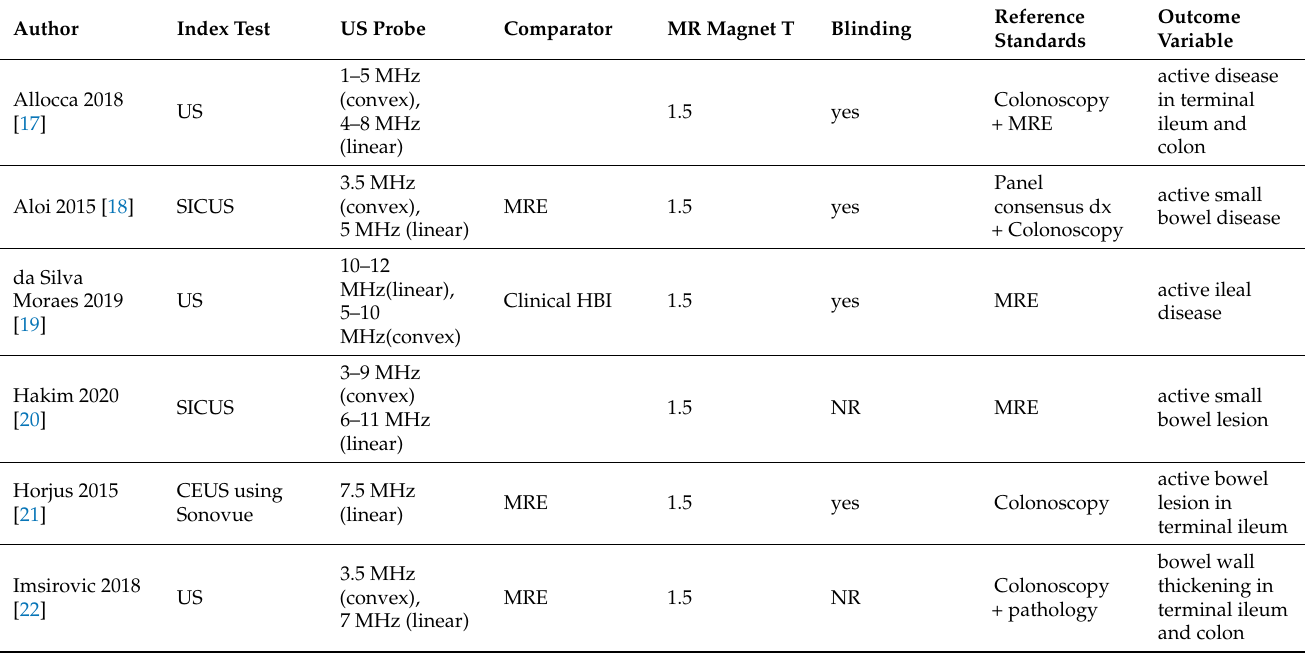
Table 2. Study characteristics regarding imaging